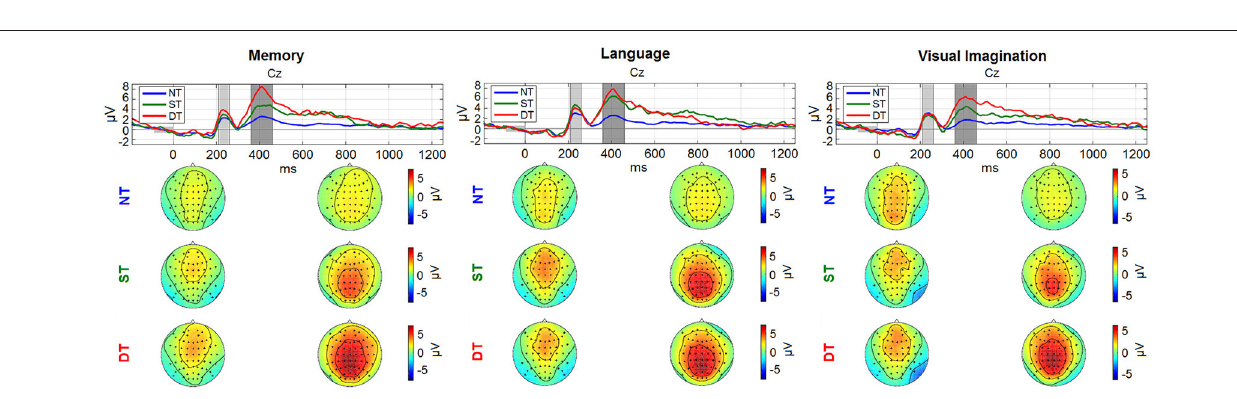
FIGURE 6 | Grand average ERPs: (a) Memory condition ; (b) Language ; (c) Visual imagination . The upper plots represent the time evolution at representative electrode Cz for the non-processing (blue line), shallow processing (green), deep processing (red). The scalp plots underneath show the topographies ( − 2 to 8 µ V 2 ) referring to the shaded areas (210–260 ms; 360–460 ms) highlighted in the time plots. The figure (with scaling adjustments) was taken from Nicolae et al. (2015a), with permission from the IEEE